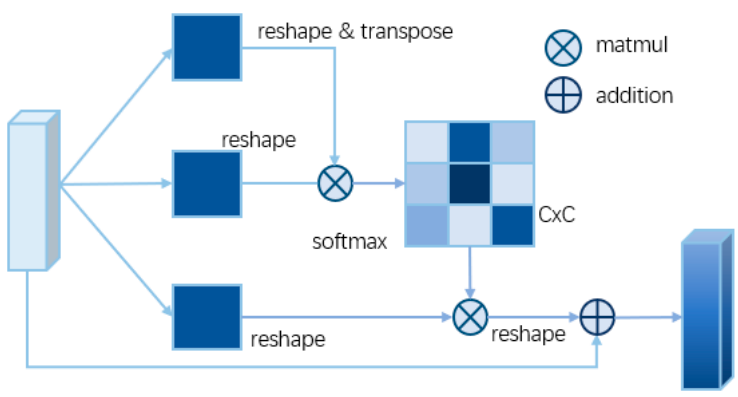
Figure 5. Architecture of the position attention module [30].